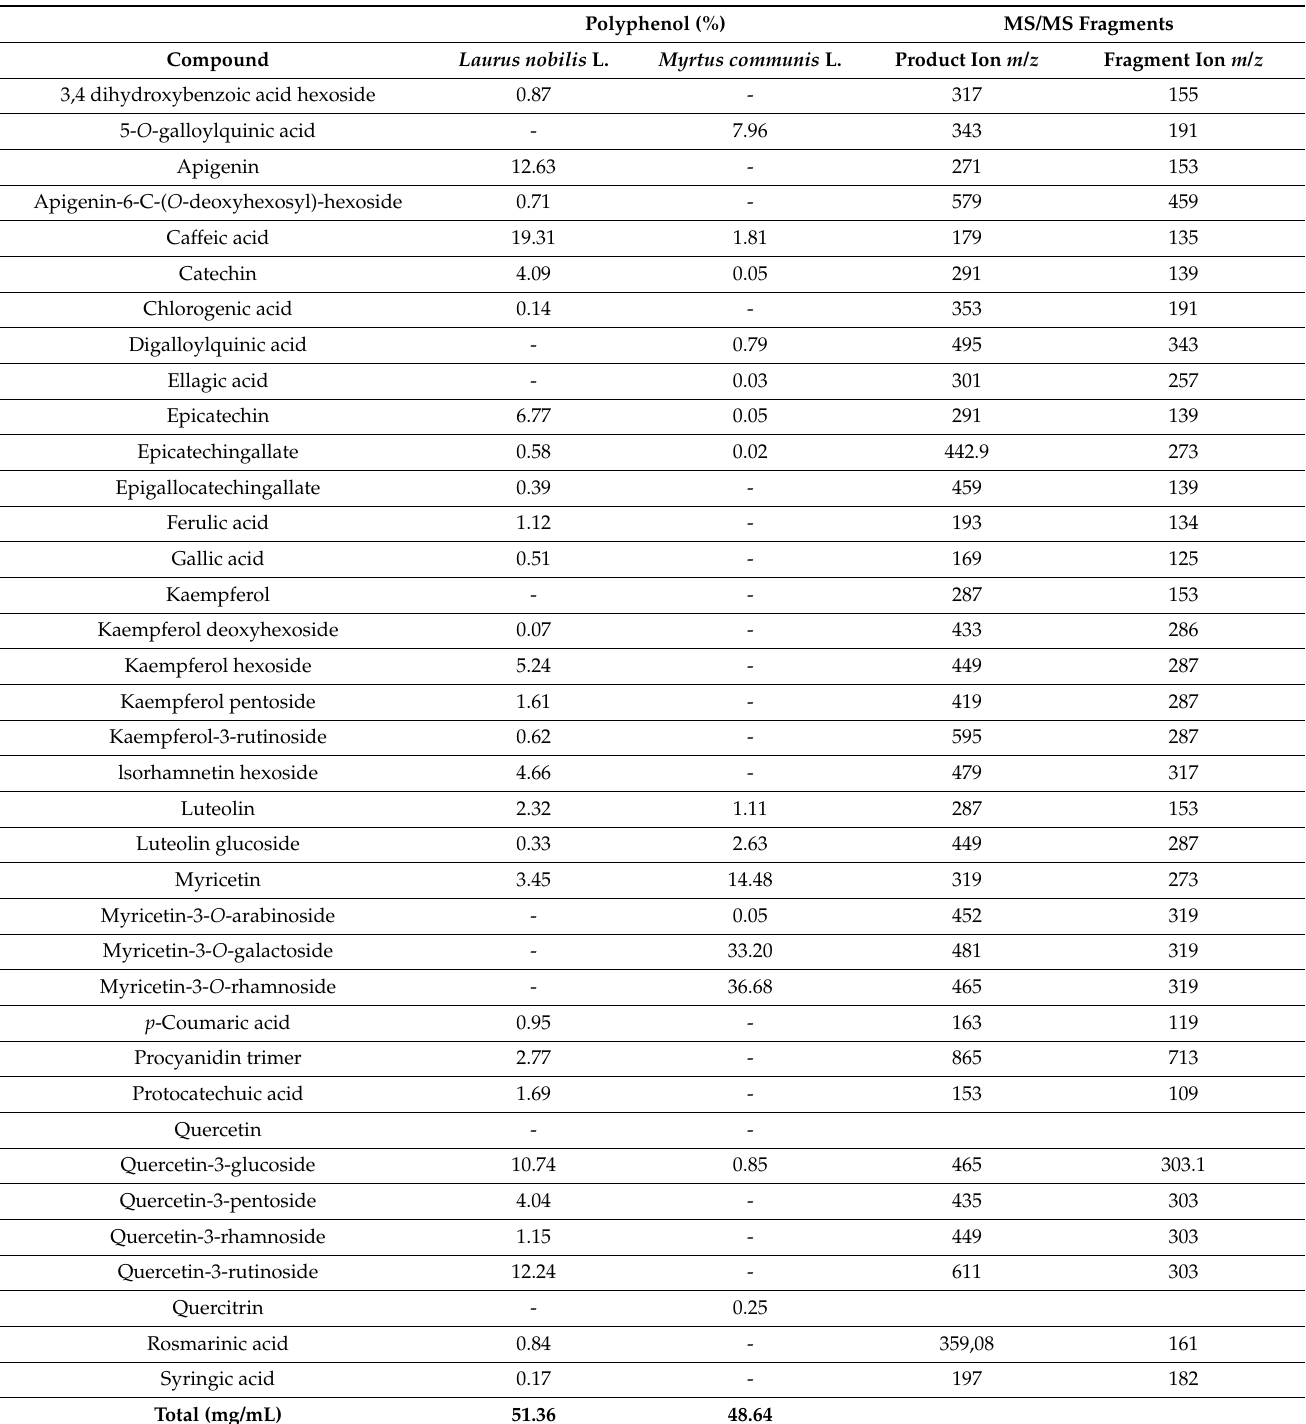
Table 1. Main components (%) in water extract of Laurus nobilis L. and Myrtus communis L. detected by UPLC-MS 2 analysis. Polyphenol (%) MS/MS Fragments Laurus nobilis